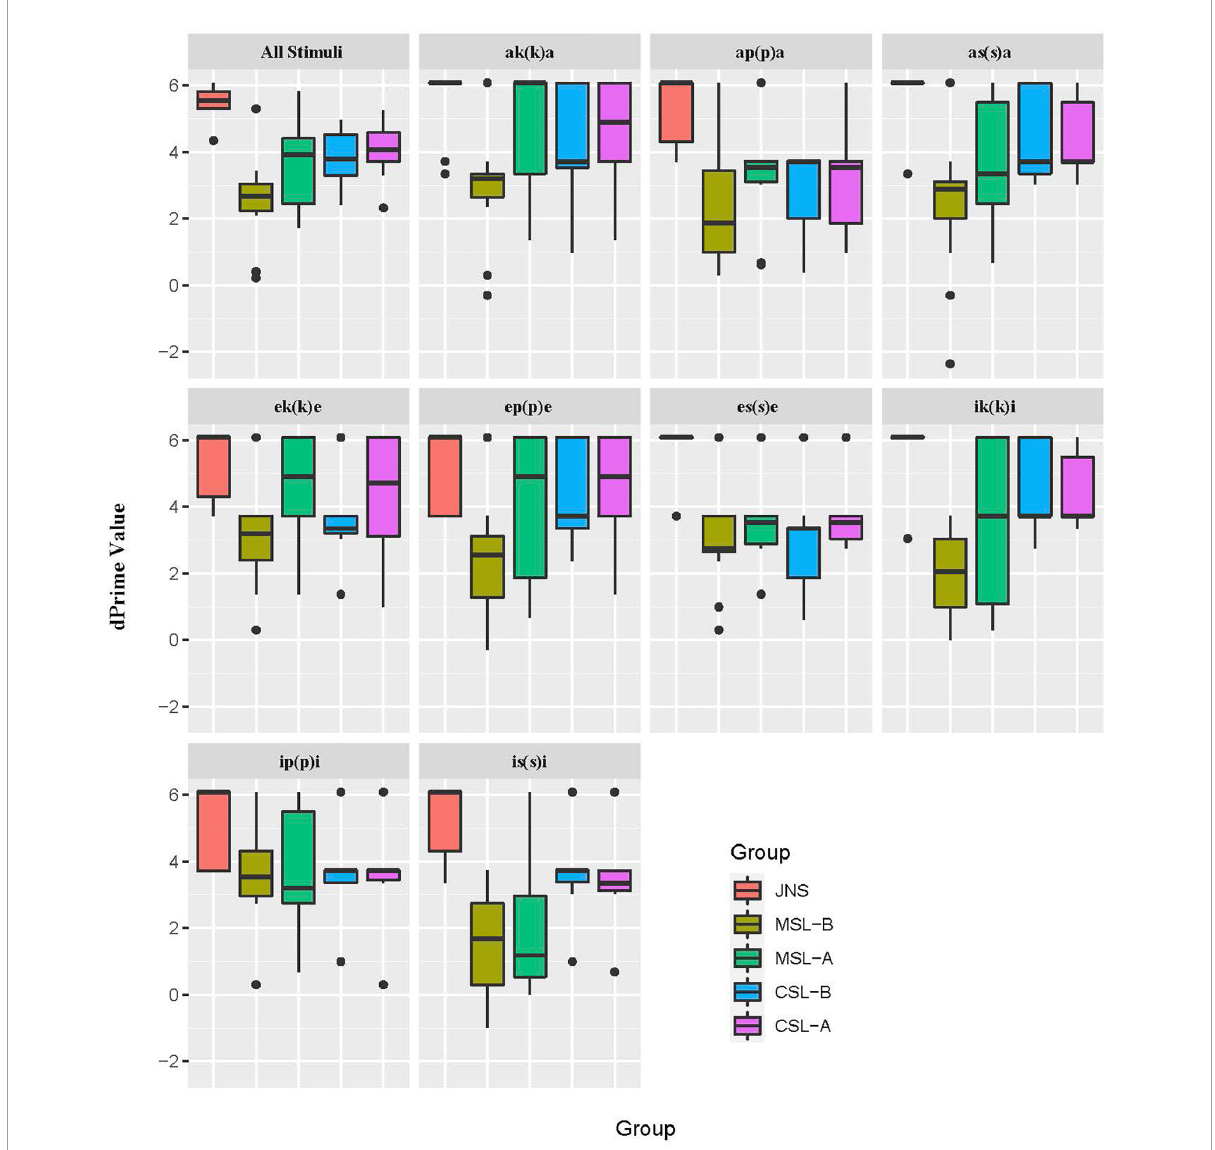
FIGURE1 The average perceptual sensitivity by all groups of participants for all non-synthesized stimuli and for each minimal pair. –B, beginner group; –A, advanced group (e.g., MSL-B, beginner group of Mandarin-speaking learners; CSL-A, advanced Cantonese-speaking learner group).